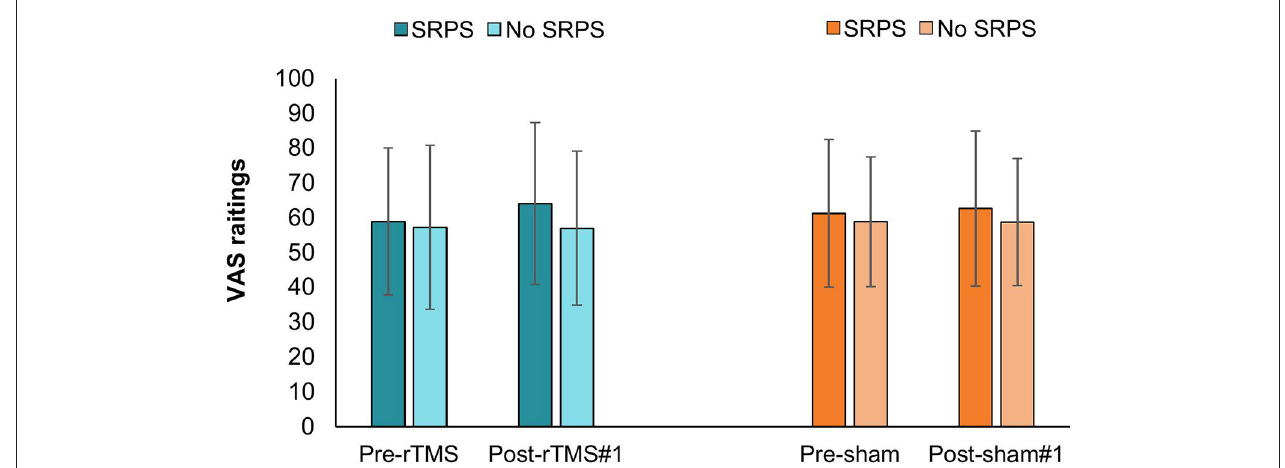
FIGURE 3 | Fluctuations in VAS expectation ratings according to time × SRPS exposition during rTMS and sham visit. rTMS, repetitive transcranial magnetic stimulation; SRPS, surreptitious reduction of pain stimulus; VAS, visual analog